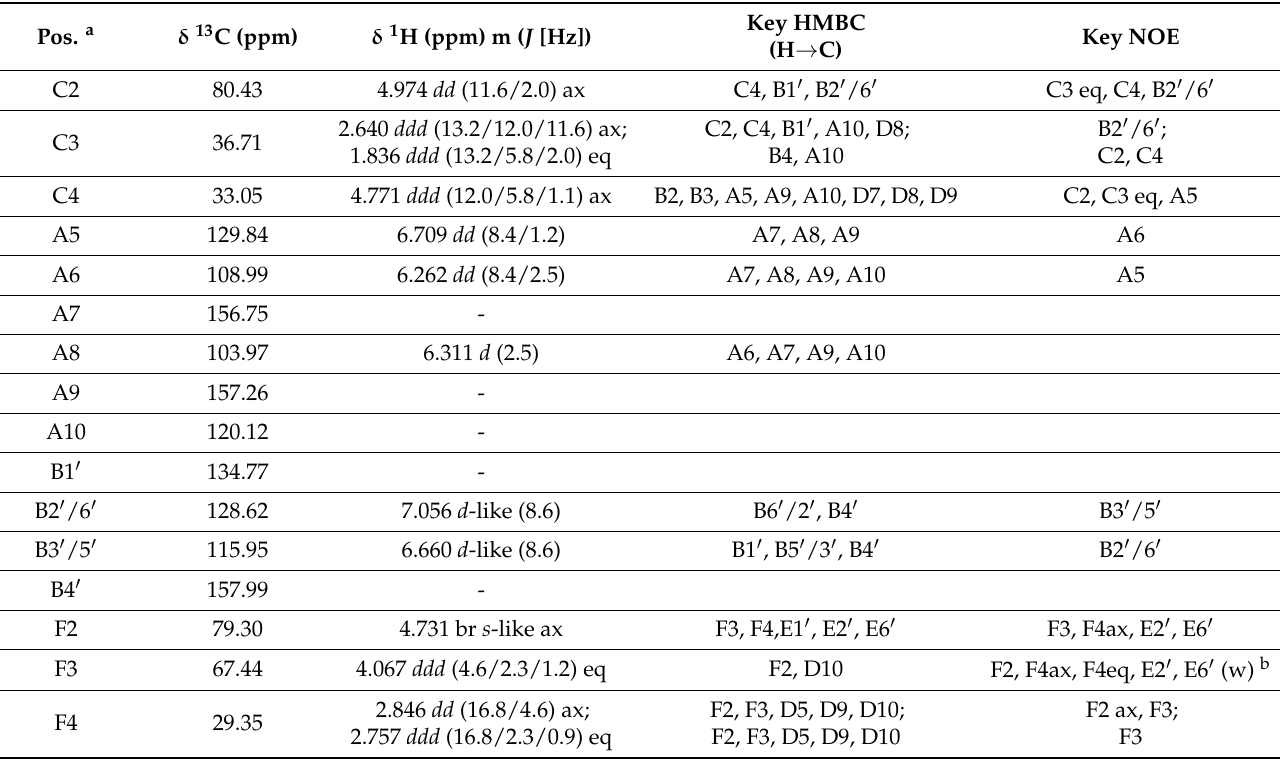
Scheme 1. Structure of compound 1 with axial position of the protons at C2, C4, and F2, as well as the OH group at F3, and the key HMBC correlations. Table 1. NMR data (600/150 MHz, CD 3 OD, +25 °C) of the major rotamer of entcassiaflavan-(4 β → 8)- epicatechin ( 1 ).